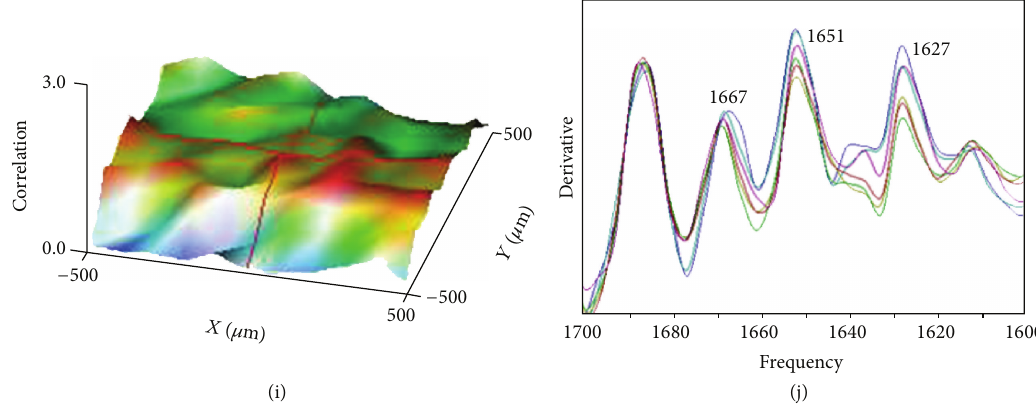
Figure 1: SEM images and Chemical Imaging analysis of nonmicrostructured PLGA/gelatin 70/30 material. (a) SEM image before and (b) after contact with water; (c) chemical map of the surface before and (d) after 15 days of degradation; (e) FT-IR spectra of the sample before and (f) after 15 days of degradation; (g) FT-IR spectrum of pure gelatin; (h) FT-IR spectrum of pure PLGA; (i) correlation map with respect to gelatin spectrum material; (j) deconvolution of amide I band of bioartificial material.